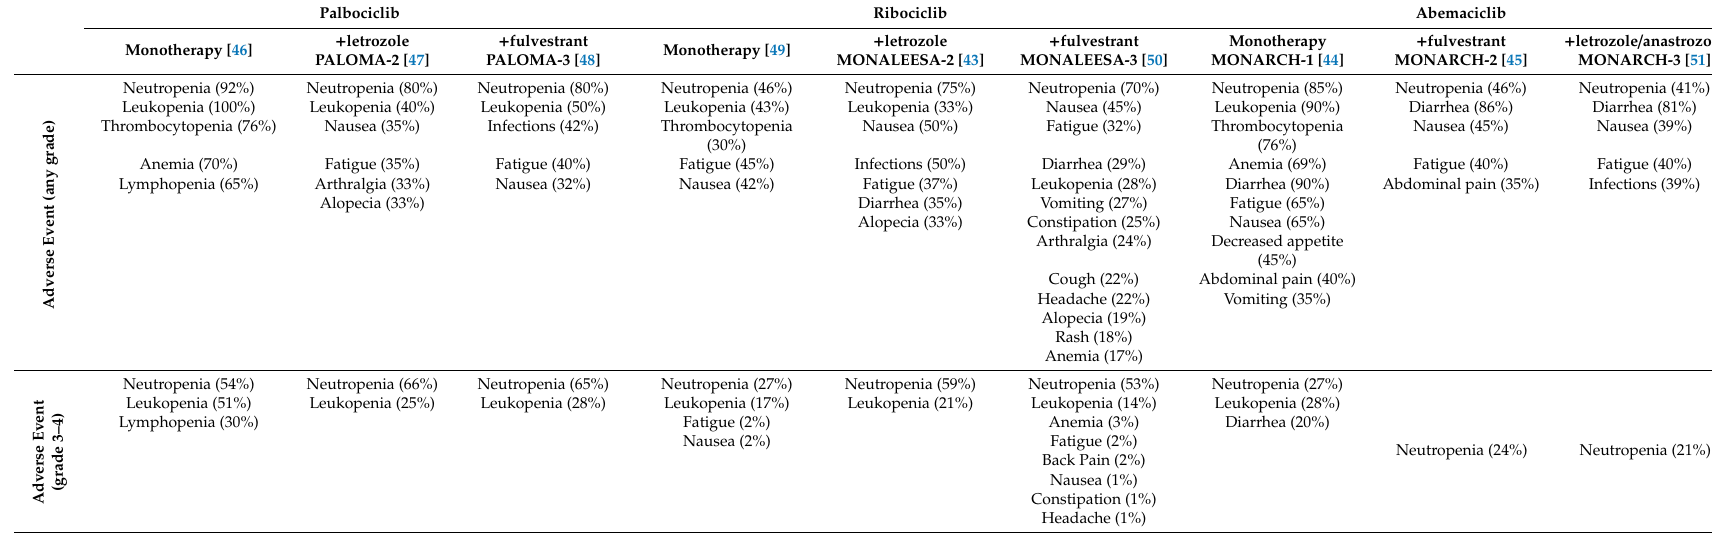
Table 1. Cyclin-Dependent Kinases (CDK)4 / 6 inhibitors’ toxicity